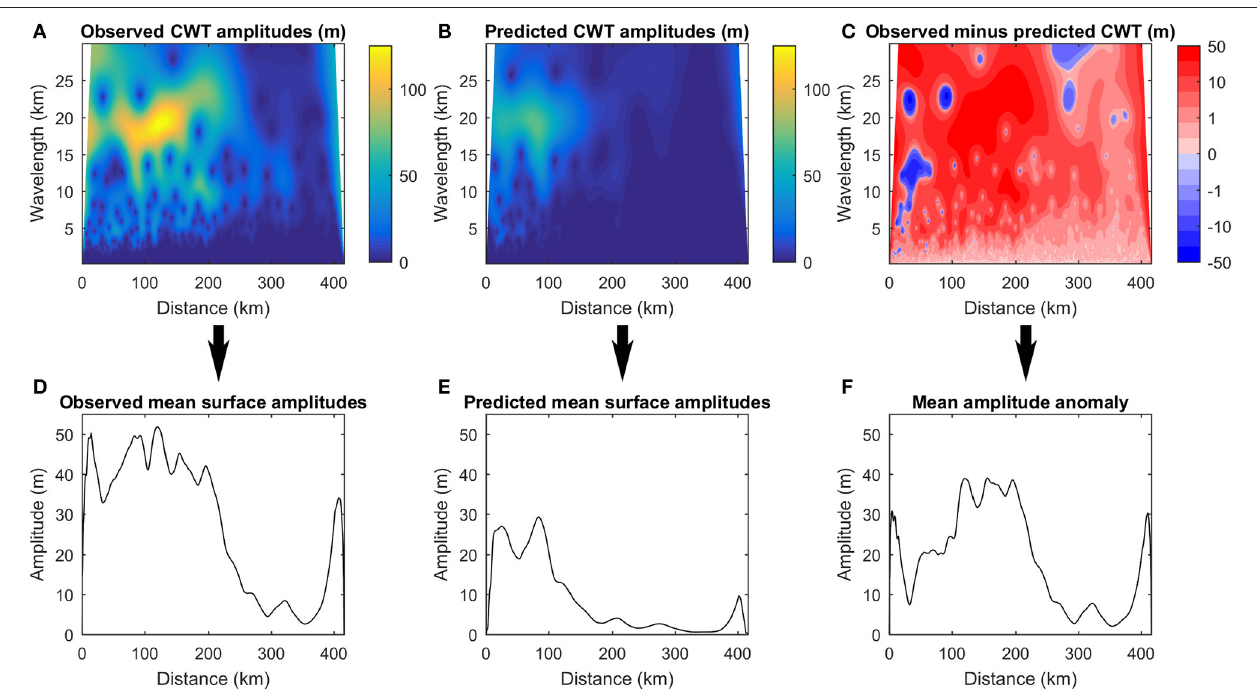
FIGURE 3 | (A) Continuous wavelet transforms (CWT) of the observed (B) and predicted surface undulation profiles along the flowline in Figure 1 . In these “scalograms,” CWT amplitude measures the strength of variability (thus, undulation amplitude) of different wavelengths at different positions. (C) Amplitude difference between (A,B) is also shown. The lower plots, made by averaging the upper plots over different wavelengths, quantify the (D) observed (E) and predicted mean mesoscale surface undulation amplitudes (F) and the mean amplitude anomaly along the